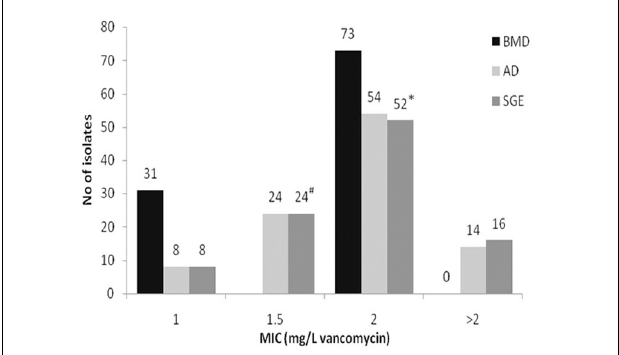
FIGURE 1 | Comparison of vancomycin MICs of porcine MRSA by broth microdilution (BMD) [from Ho et al. (2012)], agar dilution (AD), and spiral gradient endpoint technique (SGE). # Two isolates displayed a sub-population above 2.0mg/L (hVISA). ∗ Five isolates displayed sub-populations by Macro Etest; of these, three isolates displayed sub-populations by Glycopeptide Resistance Detection. The latter